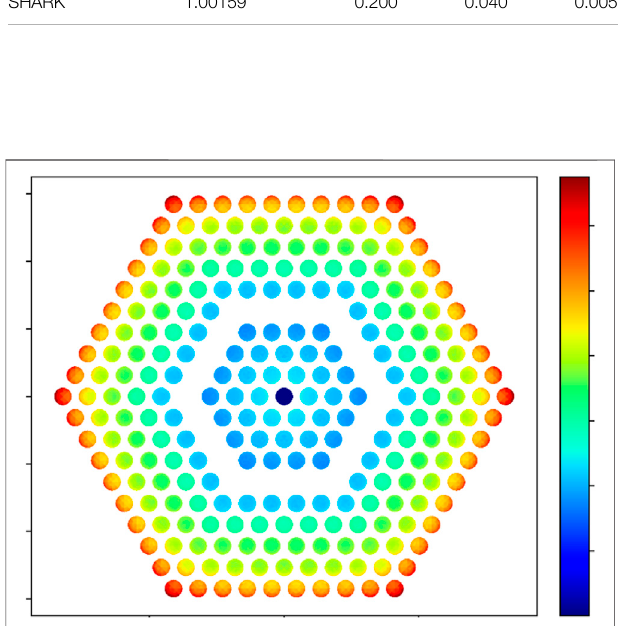
FIGURE 7 | The pin-cell fi ssion rate results of the hexagonal assembly